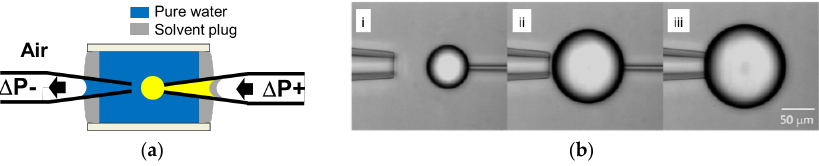
Figure 3. Single microdroplet catching method. ( a ) Two micropipettes, sample-filled (loading, right hand) and water-filled (catching, left hand) pipettes, were inserted in a water-filled glass chamber under proper applied pipette pressure for each one. The chamber was sealed with hexadecane plugging after the pipettes were inserted; ( b ) Microdroplet dissolution in medium at 20 °C. A microdroplet was formed by injection with the loading micropipette (i), and it was trapped instantly with the catching pipette just by capillarity forces (ii, iii). The isolated microdroplet dissolved gradually into the surrounding medium phase, and all the process was recorded continuously for the subsequent video analysis.